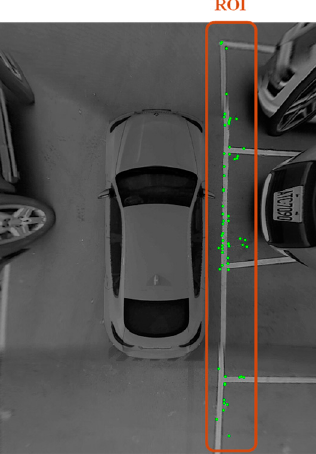
Figure 5. Feature detection results.